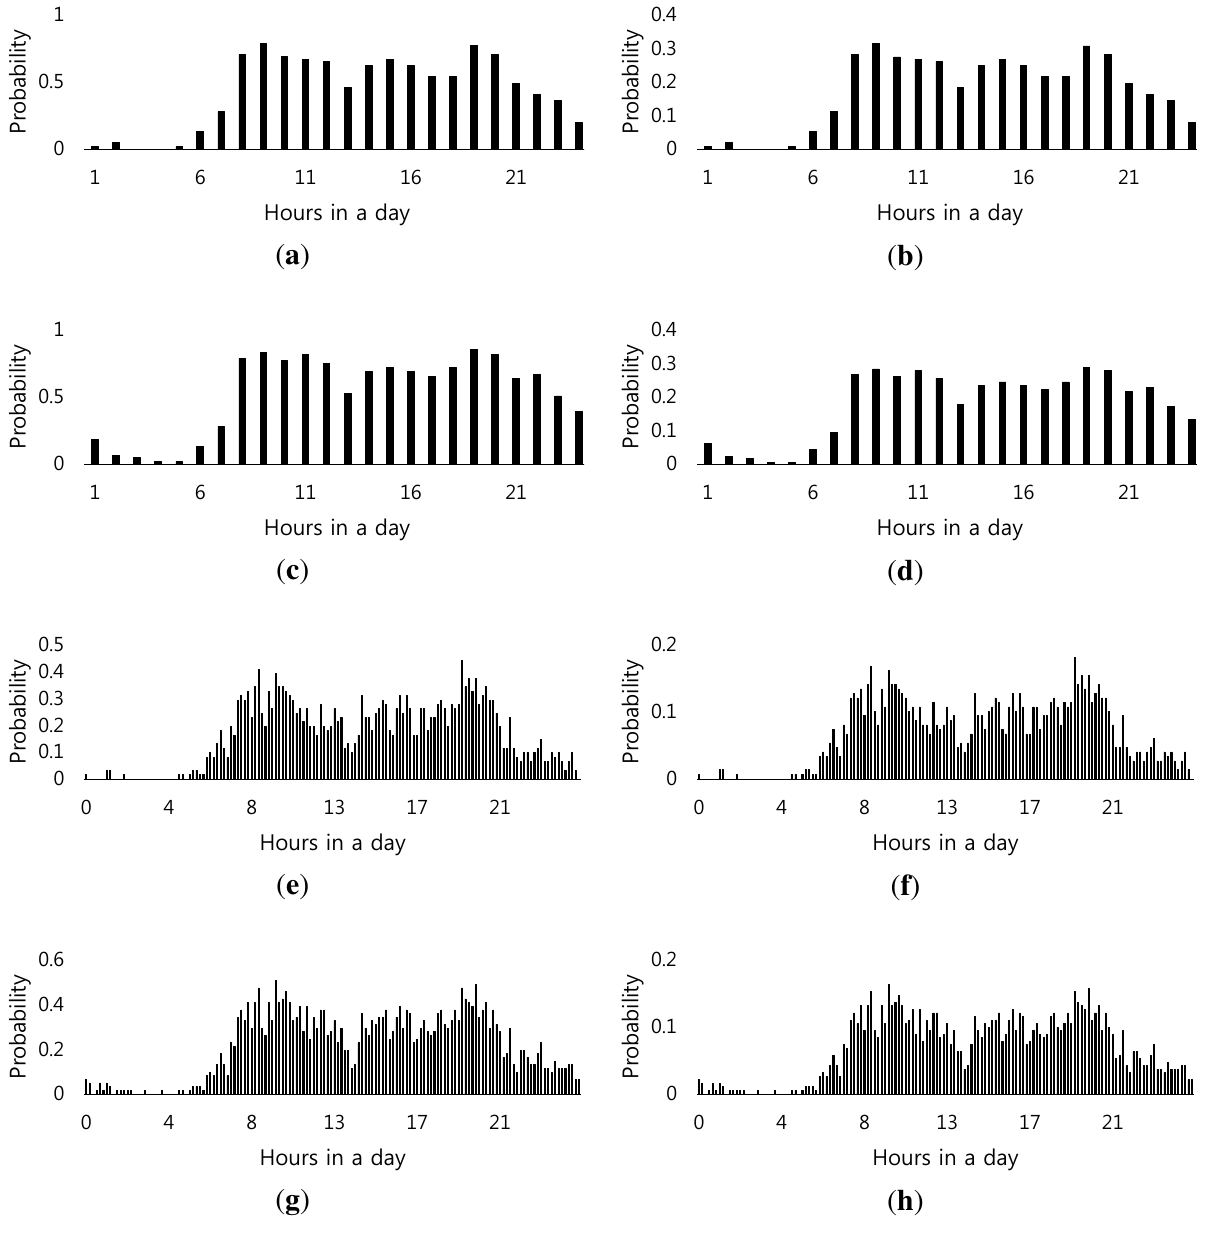
Figure 3. Probability mass functions (PMF) for kitchen and dining room